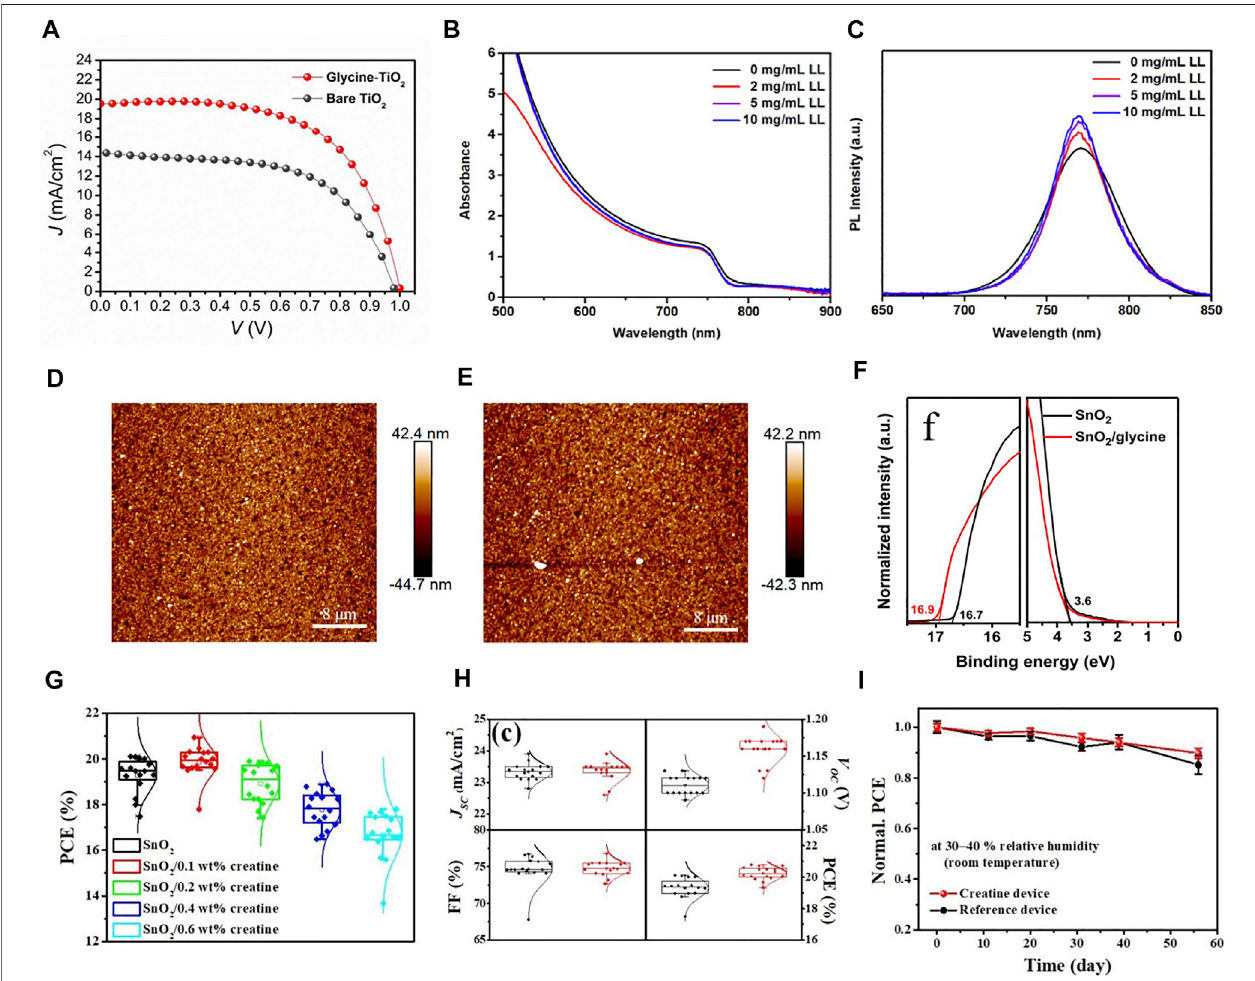
FIGURE 8 | (A) J-V curves of perovskite solar cells with bare TiO 2 and glycine treated TiO 2 . (B) UV-Vis and (C) PL spectra of perovskite fi lms fabricated using different concentrations of l-leucine. AFM images of SnO 2 (D) and modi fi ed SnO 2 (E) . (F) UPS spectra of SnO 2 and SnO 2 /glycine thin fi lms on ITO substrates. (G) Histogram of the PCE of the initial optimization of the concentration of creatine precursor. (H) Histograms of all parameters for reference device (black) and 0.1 wt% creatine device (red). (I) Stability changes of 0.1 wt% creatine device and control group.